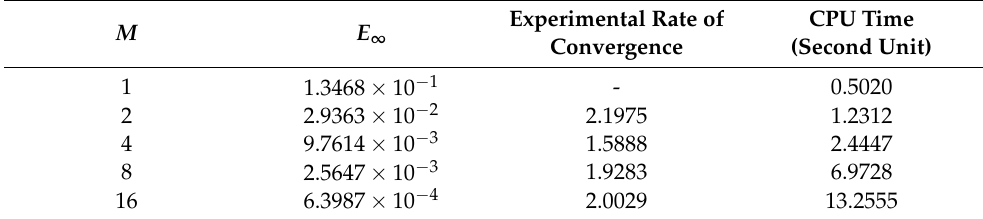
Table 1. The numerical results at ∆ τ = 0.0001, and T = 1 for Test Problem 1. Theoretical rate of convergence is 2 (see Theorem